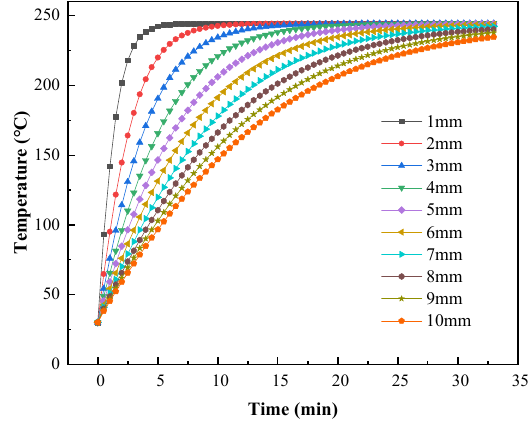
Figure 22. Predicted coating temperatures with varying substrate thickness.